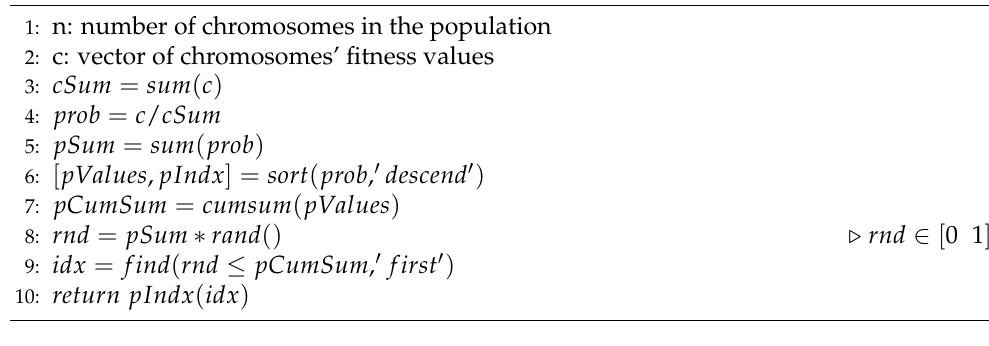
Algorithm 2 GA RWS technique.